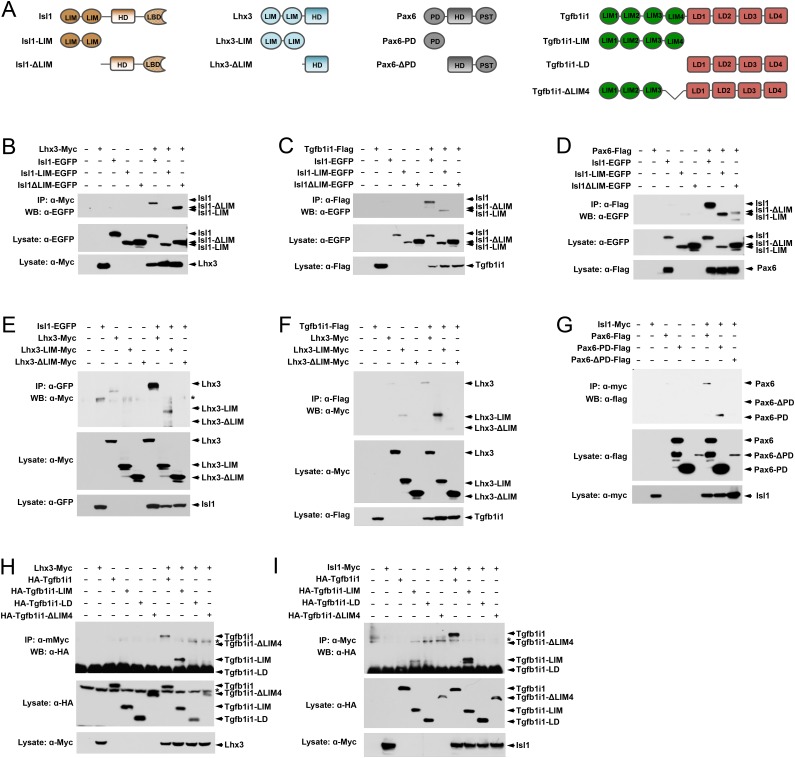
Pax6 and Tgfb1i1 antagonistically regulate Isl1-Lhx3 complex formation.(A) Schematics for the full-length and deletion mutants of Isl1, Lhx3, Pax6, and Tgfb1i1 used in these experiments. HD, homeodomain; LIM, LIM domain; LBD, LIM binding domain; LD, leucin-rich domain; PD, paired domain; PST, transactivation domain enriched in proline, sereine, and threonine. (B – I) 293 T cells (~106) were transfected with DNA constructs (10 μg total) encoding the indicated protein fragments. Cell lysates collected at 48 hr post-transfection were incubated with antibodies against the epitope tags to immunoprecipitate each protein and its binding partners. Co-immunoprecipitated proteins were then analyzed by SDS-PAGE and subsequent WB with the indicated antibodies. In parallel, the cell lysates (containing 50 μg protein) were also analyzed by SDS-PAGE and WB with the indicated antibodies to examine relative levels of the overexpressed proteins in the transfected cells.